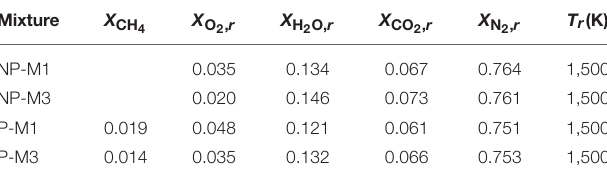
TABLE 1 | Thermochemical condition of the oxidizer for MILD